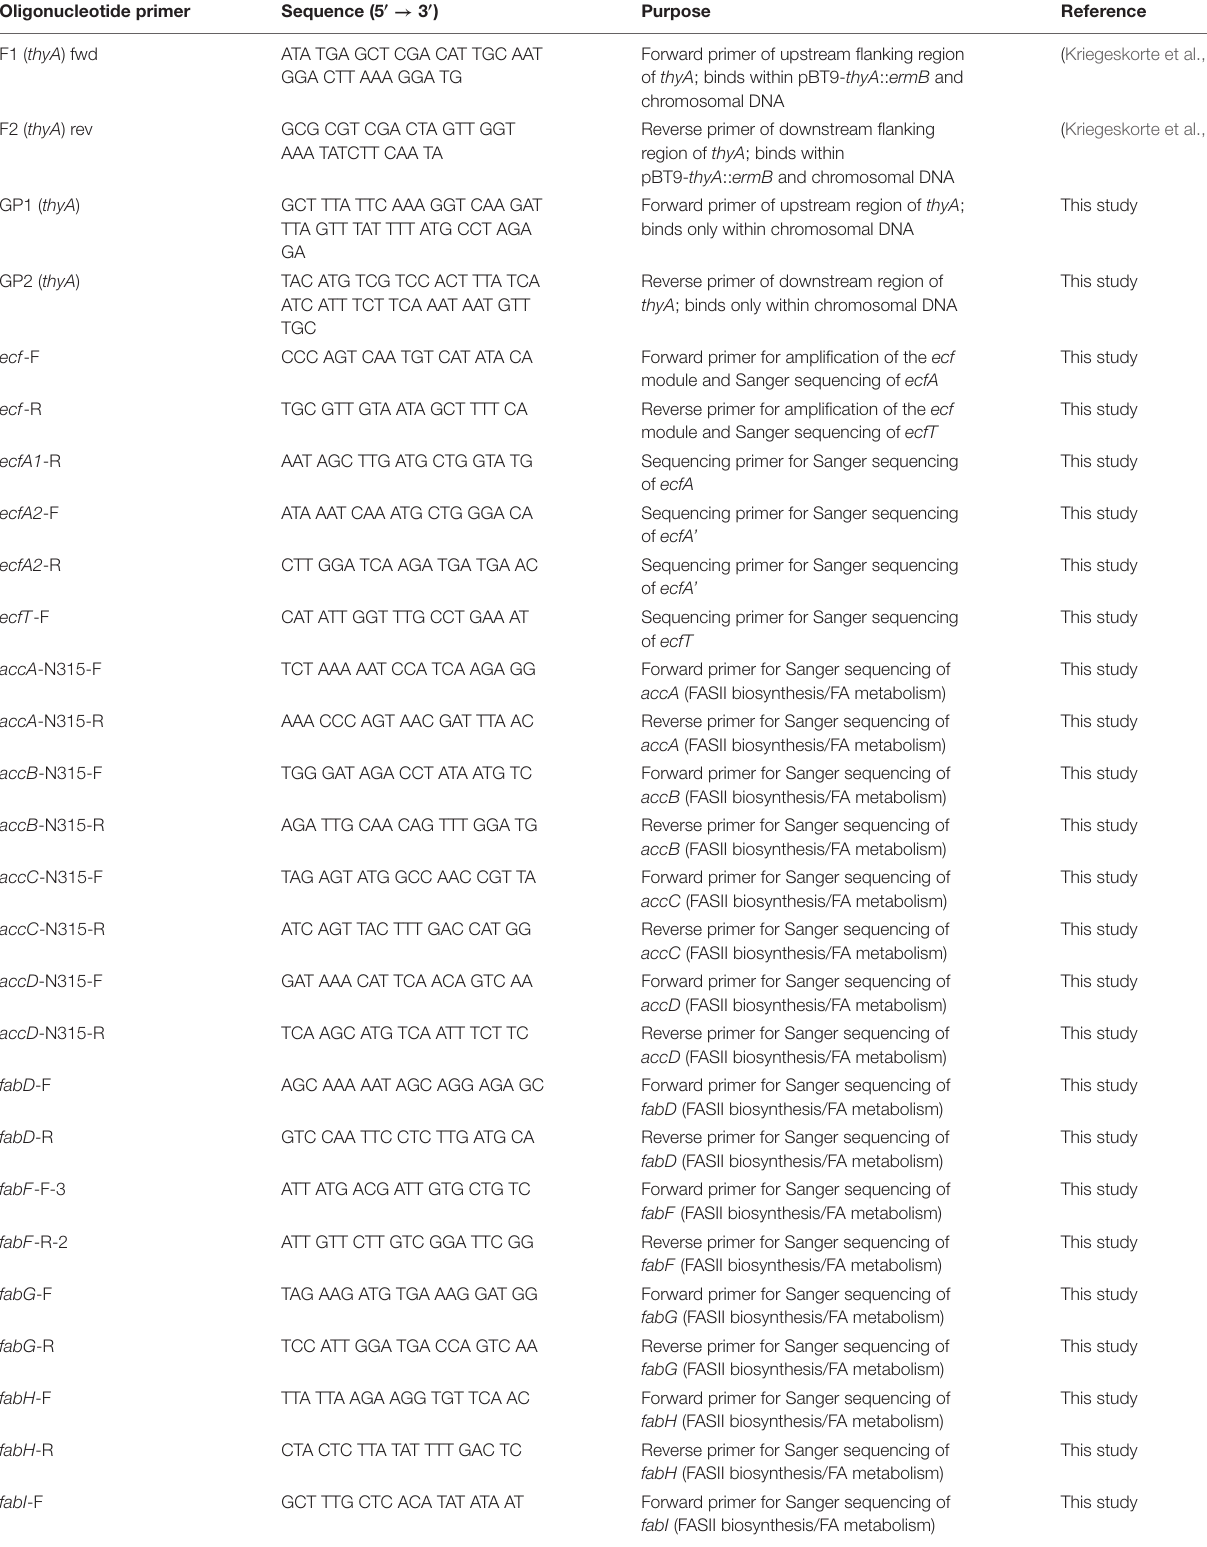
TABLE 2 | Oligonucleotides used in this study. Oligonucleotide